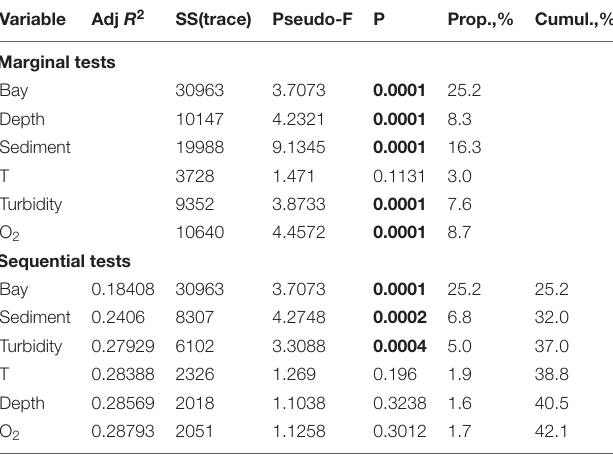
TABLE 4 | The distance based linear modeling (DistLM) procedure using forward selection, examining the relationship between environmental variables and macrofauna distribution patterns in all five investigated fjords.